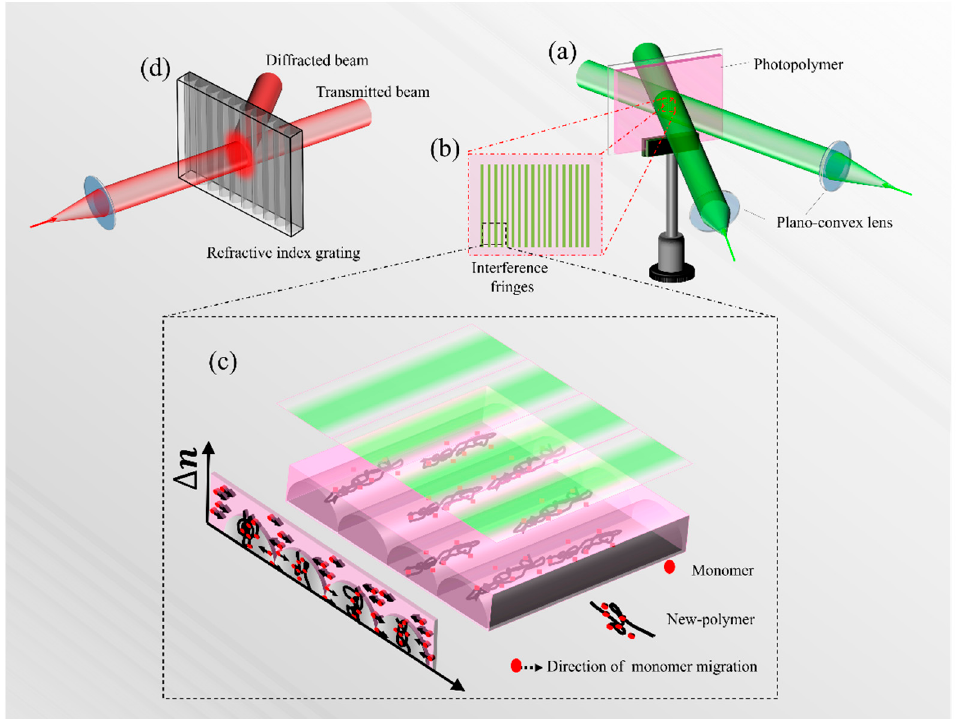
Figure 1. Schematic diagram of the recording and reproduction principle of photopolymer holography: ( a ) photopolymer exposure process; ( b ) interference fringes formed by object light and reference light; ( c ) formation process of refractive index grating inside photopolymer. ( d ) Reproduction of hologram.